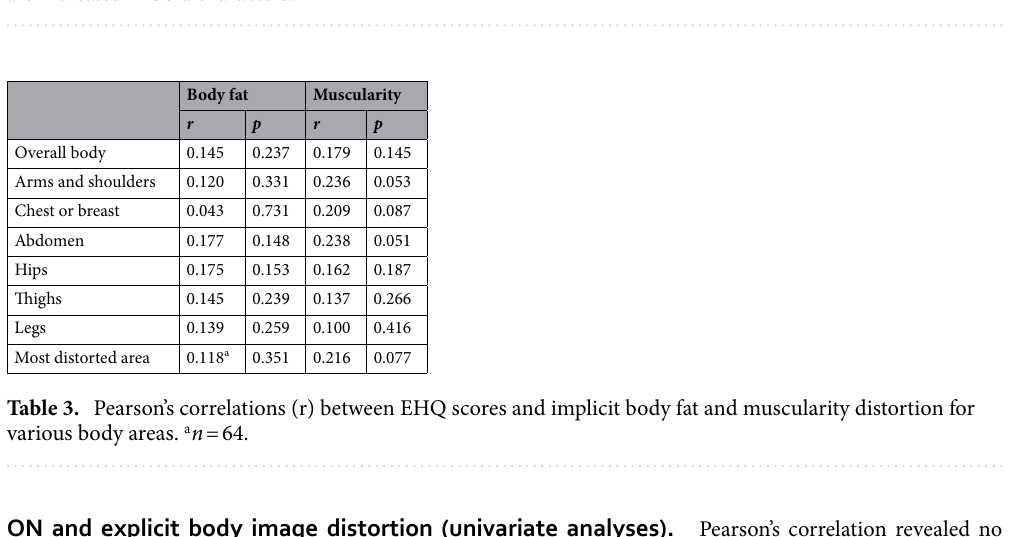
Table 2. Pearson’s correlations (r) between EHQ and MBSRQ subscales (explicit attitudes). Significant results are indicated in bold characters.